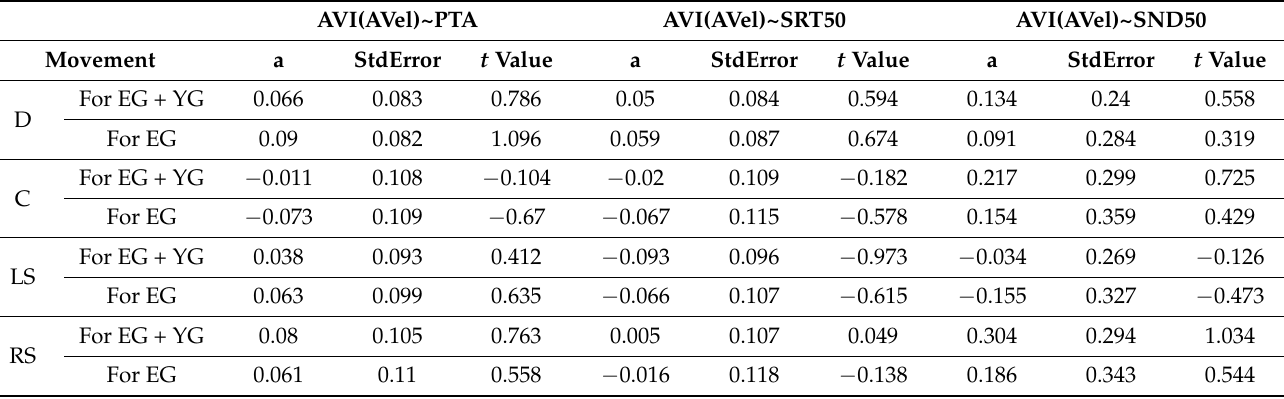
Table A2. Relations between AVI(AVel) and